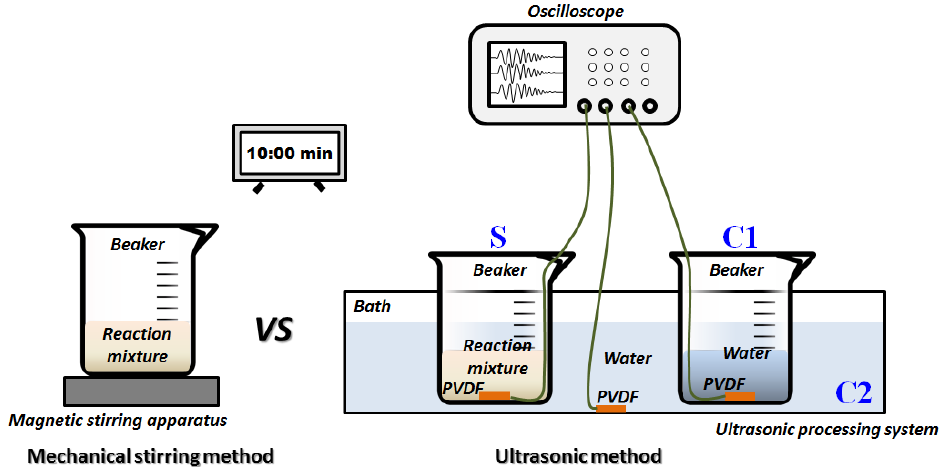
Figure 1. Schematic diagram of monitoring of ultrasonic fields during synthesis process of nano-ZnO. The data of voltage waveform from the ultrasonic fields can be converted to the acoustic pressure; therefore, the space peak temporal peak acoustic intensity, I SPTP , and the space peak temporal average acoustic intensity, I SPTA , can be deduced by using Equations (3) and (4)